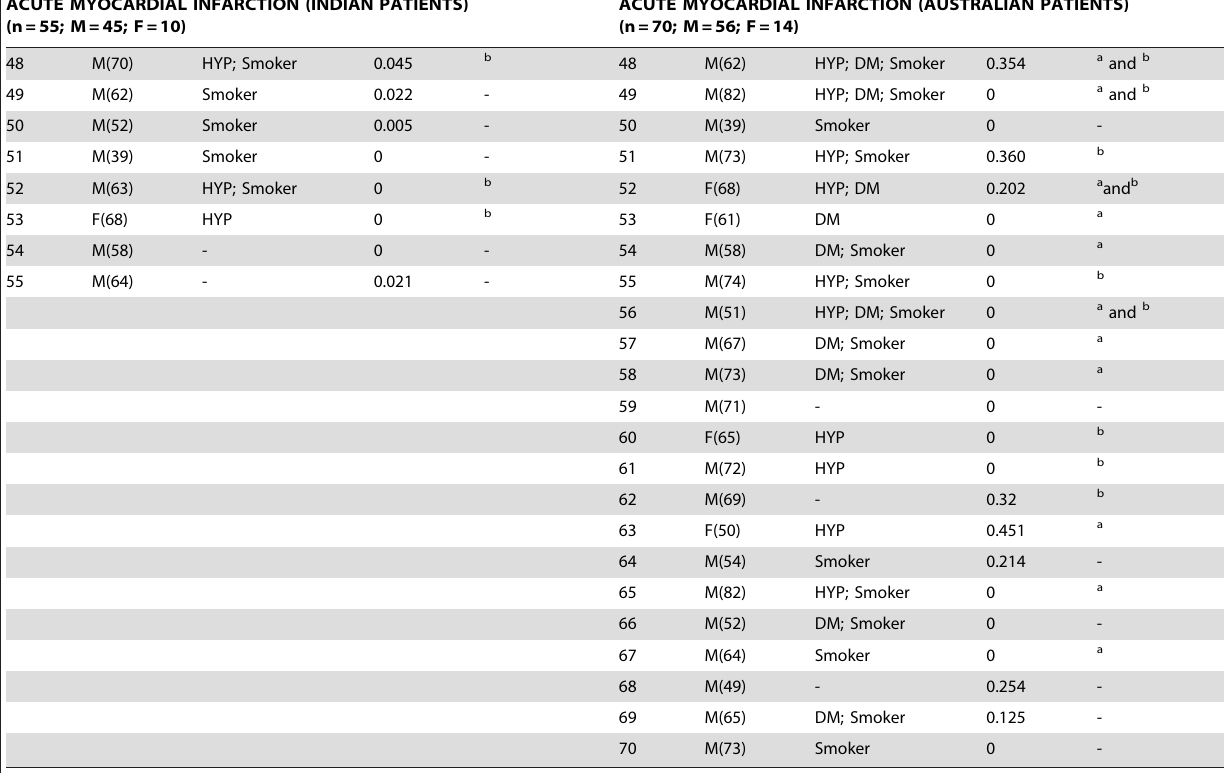
ACUTE MYOCARDIAL INFARCTION (INDIAN PATIENTS) (n=55; M=45;